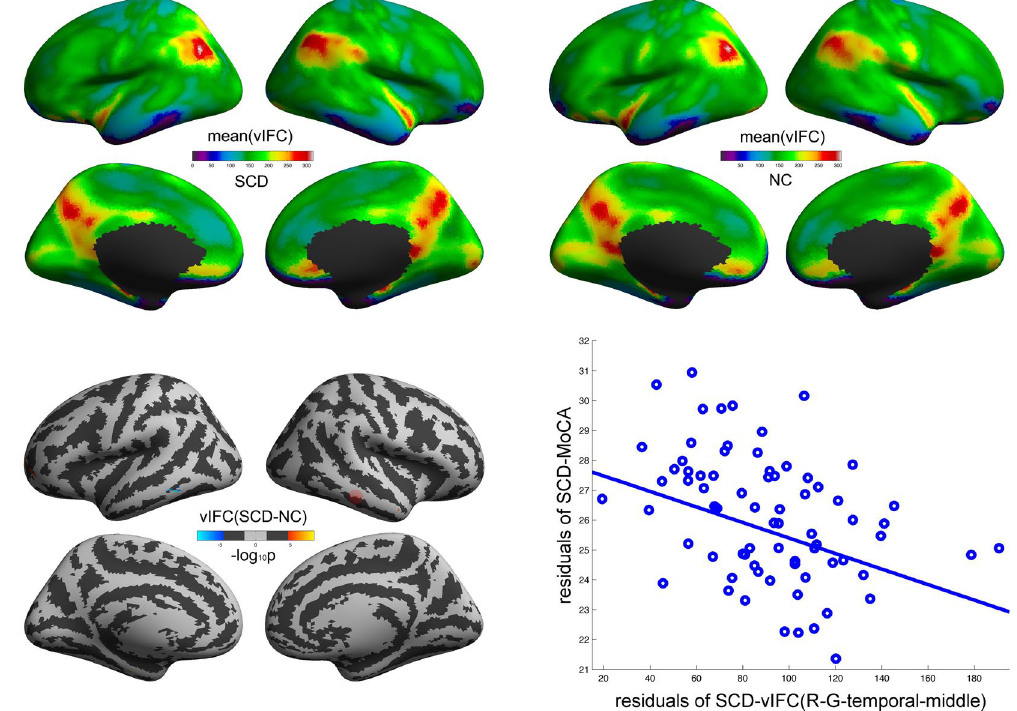
Figure 2. Significant SCD-NC differences in vIFC across cortical mantle. The cold and warm colors respectively stand for significant decreased and increased vIFC compared to normal controls (FDR α < 0.05/2, corrected p < 0.05/2). The right scatter illustrated the significant negative correlations of vIFC with MoCA in the right middle temporal gyrus (as represented by the red rings on the cortical